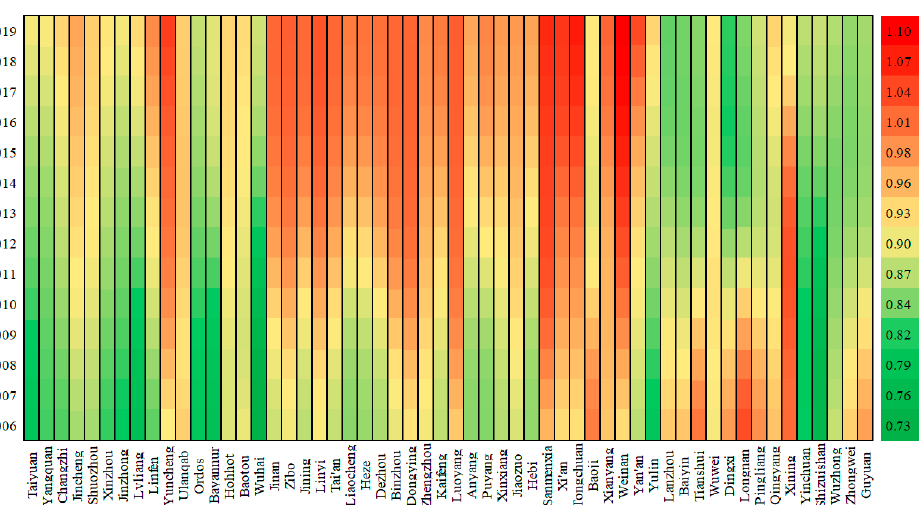
Figure 3. Heat Map of affluence coefficient.